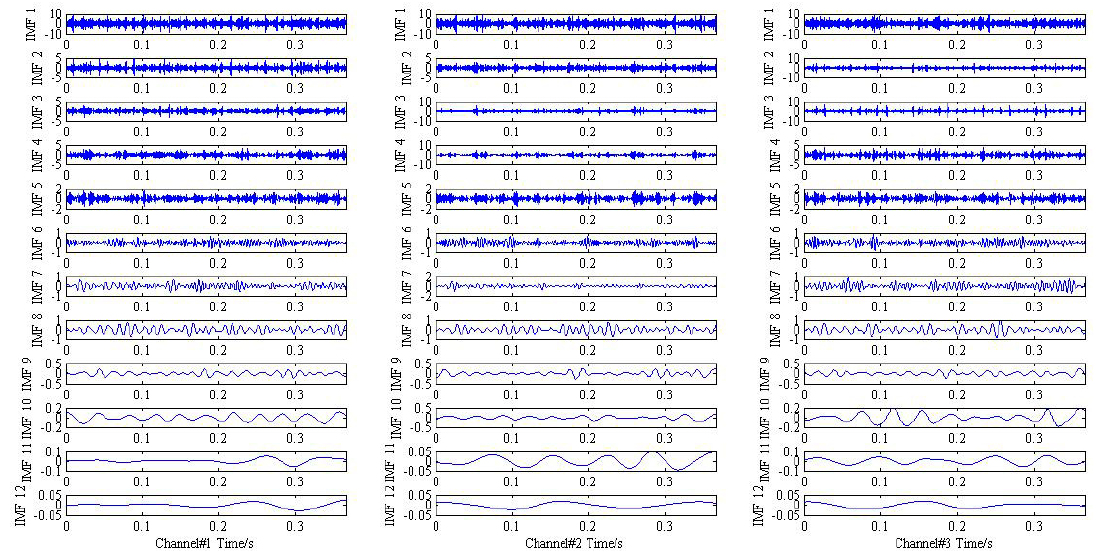
Figure 11. The result provided by the proposed method in time domain.